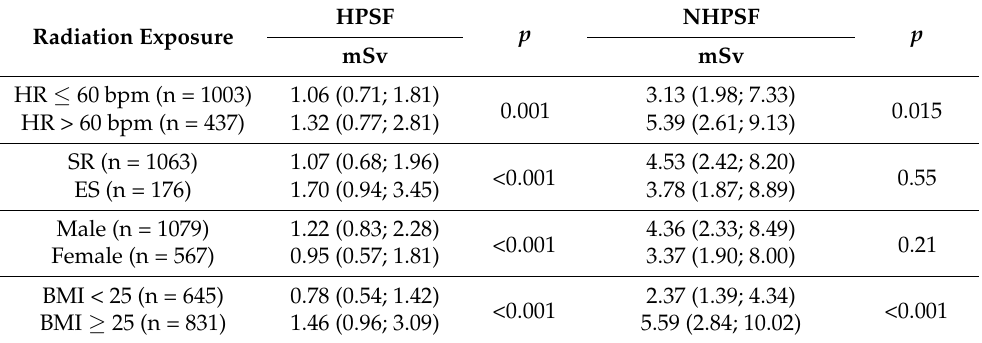
Table 4. Subgroup analysis of overall radiation exposure (mSv) as a function of selected clinical and demographical parameters. Radiation exposure with HPSF was significantly lower than with NHPSF in all subgroups ( p < 0.05). HPSF: high-pitch spiral scan first; NHPSF: non high-pitch spiral scan first; HR: heart rate; SR: sinus rhythm without extrasystoles; ES: extrasystoles; BMI: body mass index; bpm: beats per